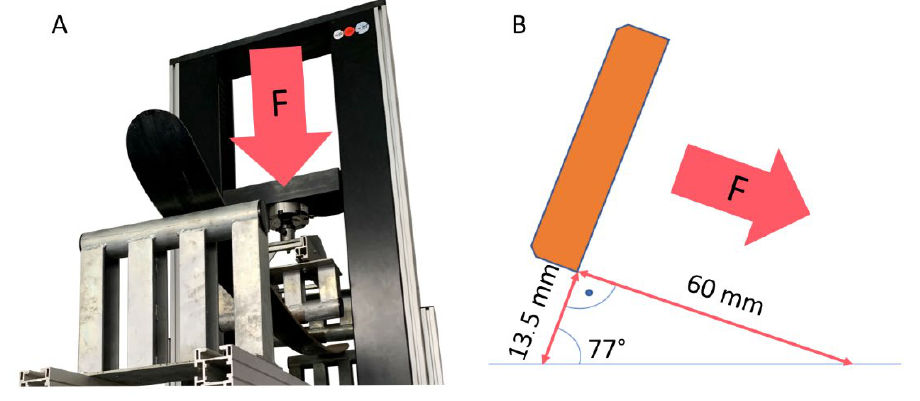
Figure 6. Testing: ( A ): Ski deflection in the test rig, ( B ): Ski deflection in the curve.